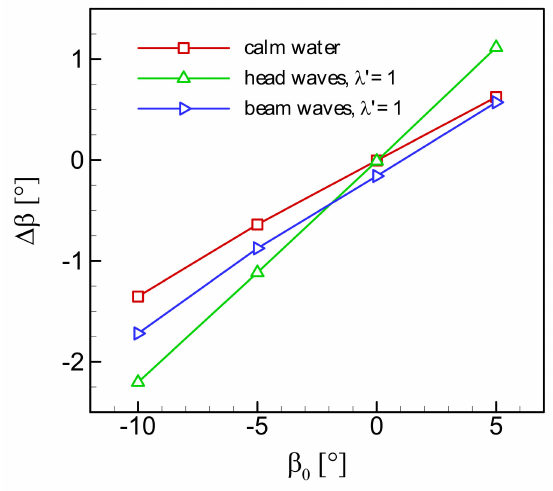
Figure 7. ∆ β versus β 0 based on